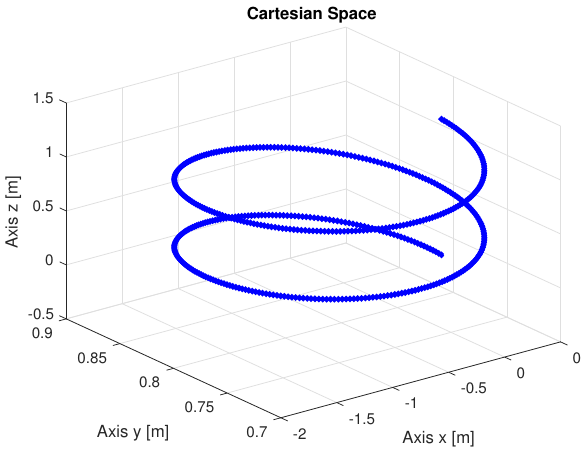
Figure 5. Trajectory executed by the manipulator in Cartesian